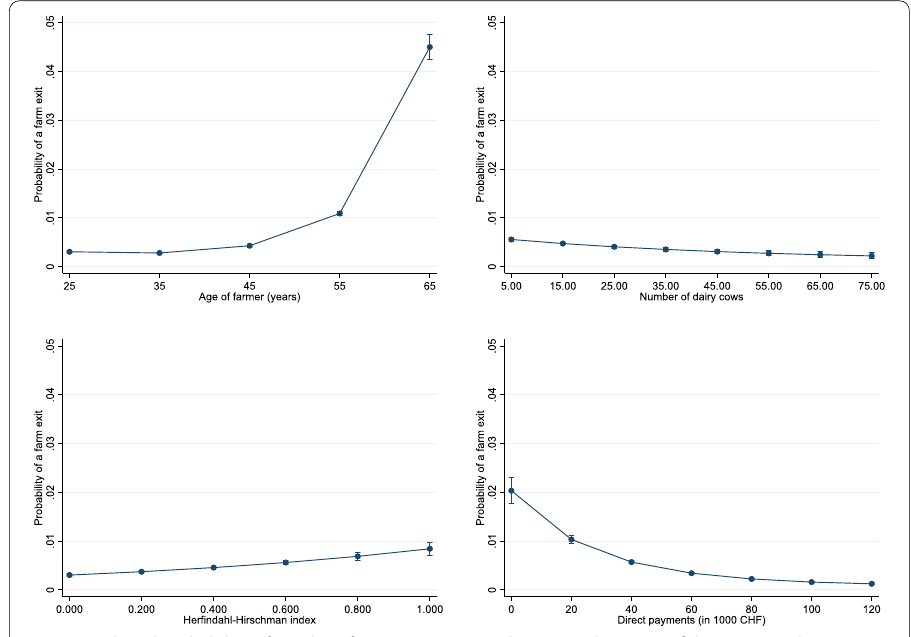
Fig. 7 Predicted probabilities for a dairy farm exit. Notes : Predictions with 95% confidence